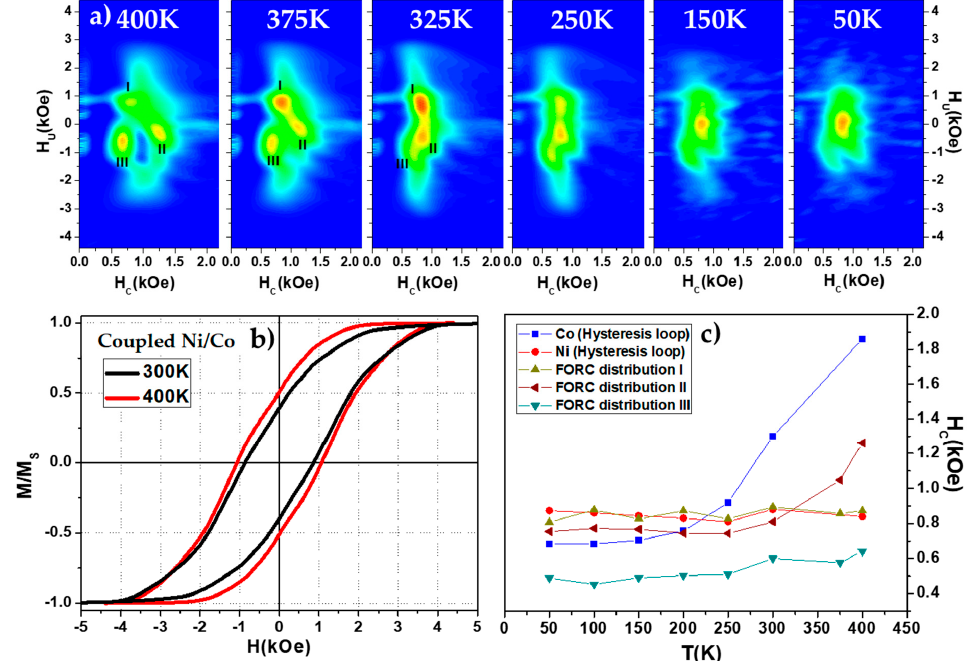
Figure 8. ( a ) Parallel FORC diagrams measured at different temperatures ranging from 400 K down to 50 K. ( b ) Parallel hysteresis loops of coupled Ni/Co bisegmented sample measured at 300 K (black) and 400 K (red). ( c ) Summarizes the coercive field of the Ni and Co hysteresis loops, and the main switching field of the different Ni/Co FORC distributions in the measured temperature range from 50 K to 400 K.